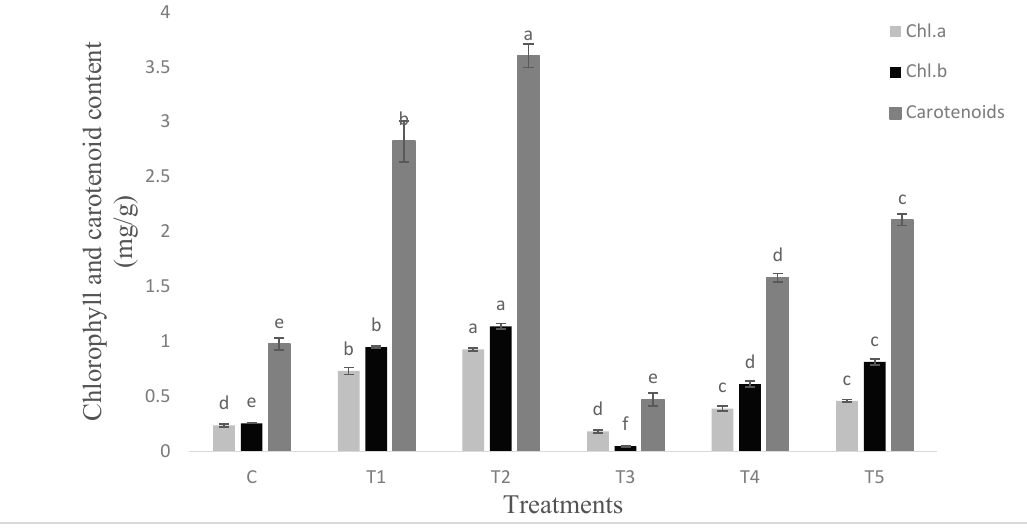
Figure 6. Chlorophylls and carotenoids content (mg / g) of tomato leaves infested with S. litura and under control condition. Data are means of four replicates along with standard error bars. Different letters are indicating significant differences ( p < 0.05) among treatments.